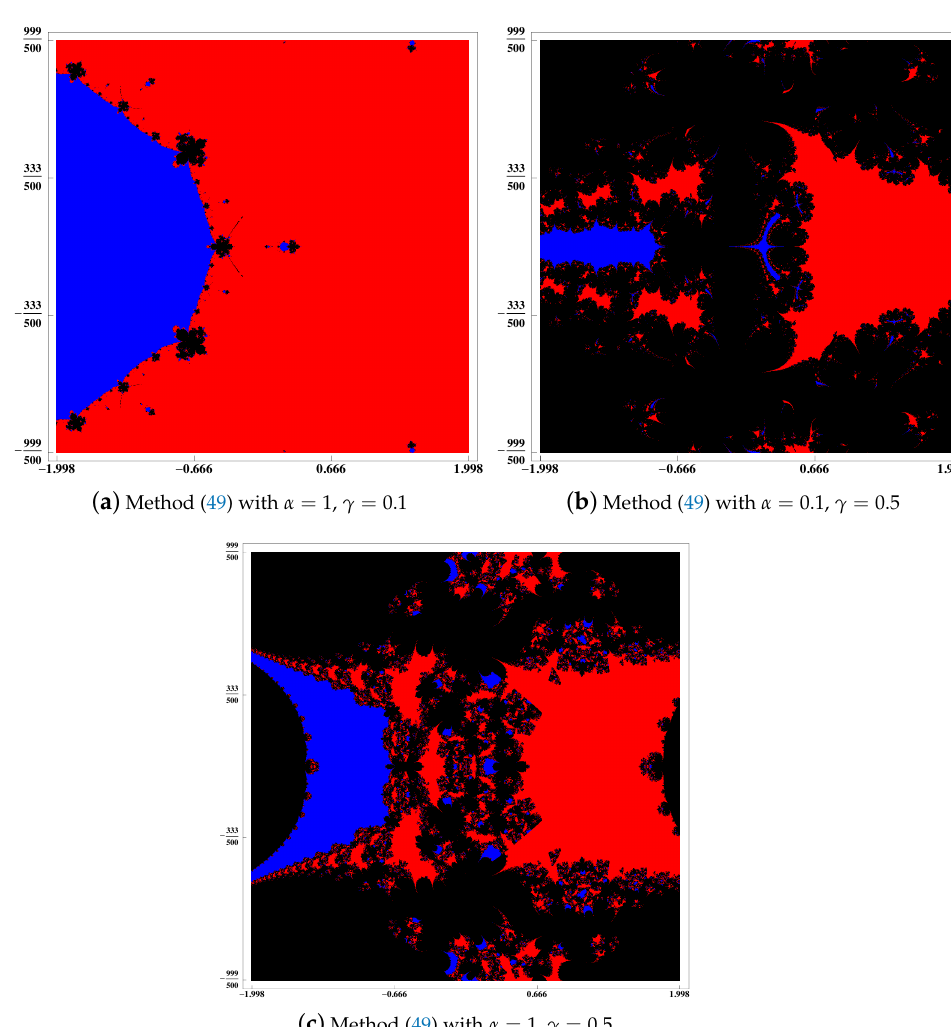
Figure 3. Basins of attraction associated to the method (49) applied to polynomial p ( z ) = ( z − 1 ) 2 ( z + 1 ) with different values for